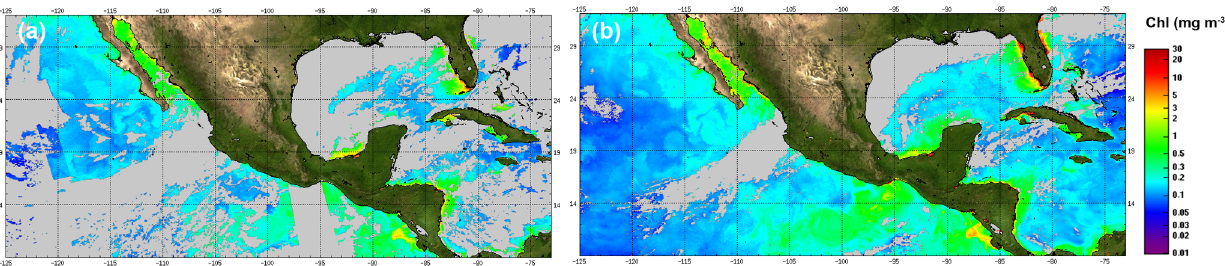
Figure 9. The chlorophyll a concentration (15 December 2017) for (a) the OC-CCI level 3 product and (b) the GlobColour